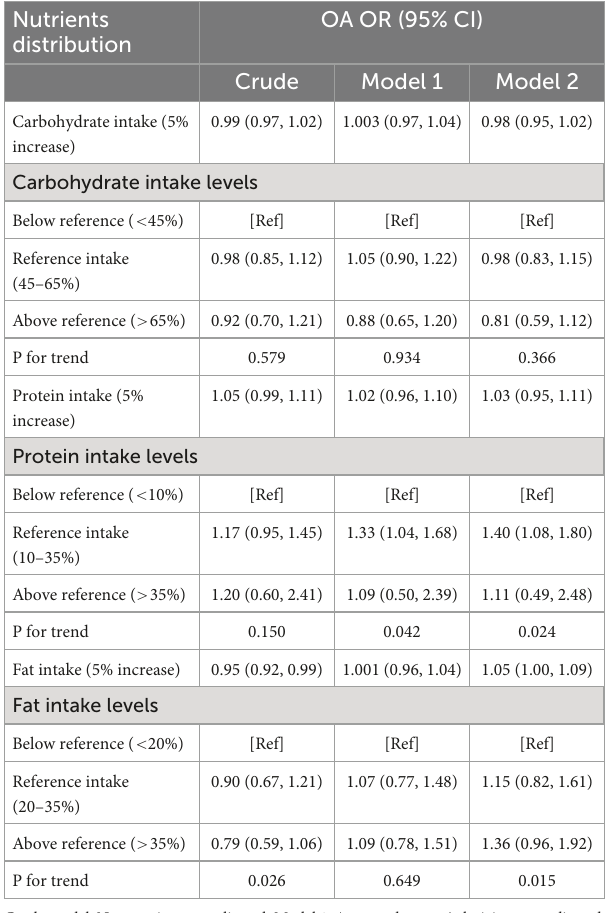
TABLE 2 Association between macronutrients distribution and the risk of osteoarthritis (OA) among 7,725 participants from 2013 to 2016 National Health and Nutrition Examination Survey (NHANES).